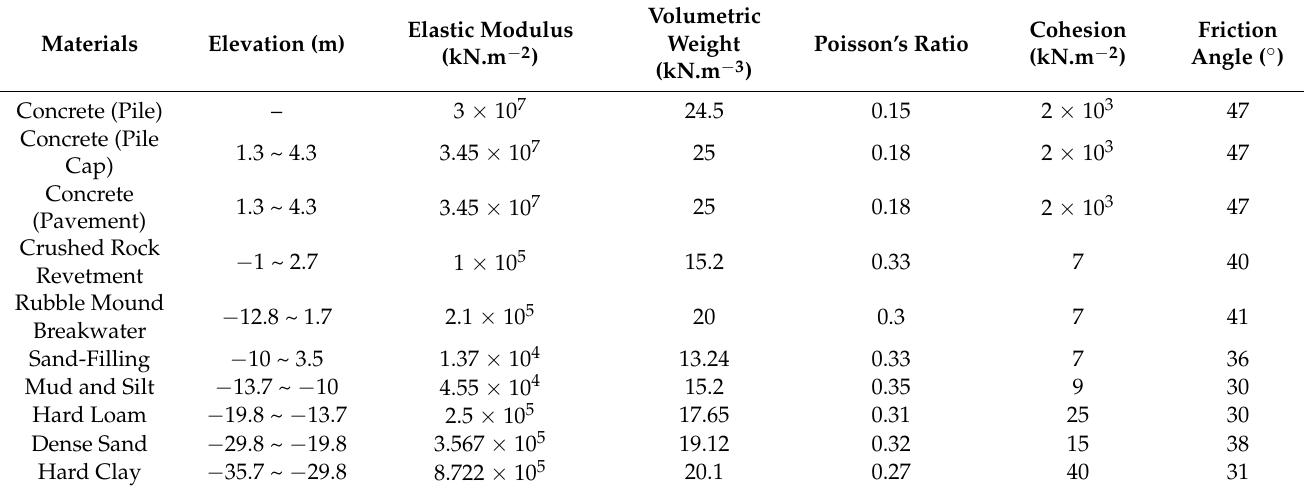
Table 1. Materials